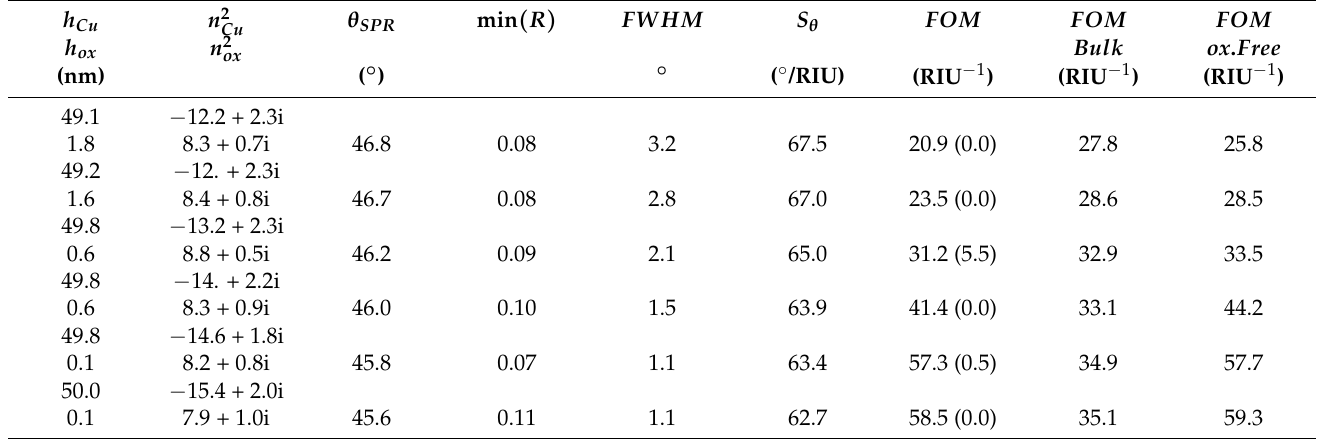
Figure 4. Simulated SPR setup signal for the samples of initial target thickness h 0 calculation uses the parameters deduced from the fitting of UV-visible-NIR absorbance curves, at wavelength λ 0 = 632.8 nm. Upper medium is air. Table 1. Calculated performance of the SPR setup given the retrieved thicknesses and optical properties in the dry case: resonance angle, the depth of SPR dip, full width at half maximum, sensitivity and figure of merit (only FOM > 20 RIU − 1 are indicated) and its uncertainty, FOM for optical properties of bulk materials, and for bare copper (without